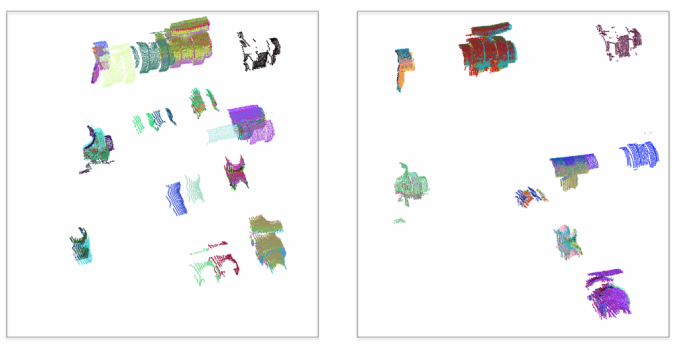
Figure 12. Mapped object point clouds: ( Left ) Located at their dead reckoning position; ( Right ) Located at the position estimated by the tracking using the IJCBB algorithm on the